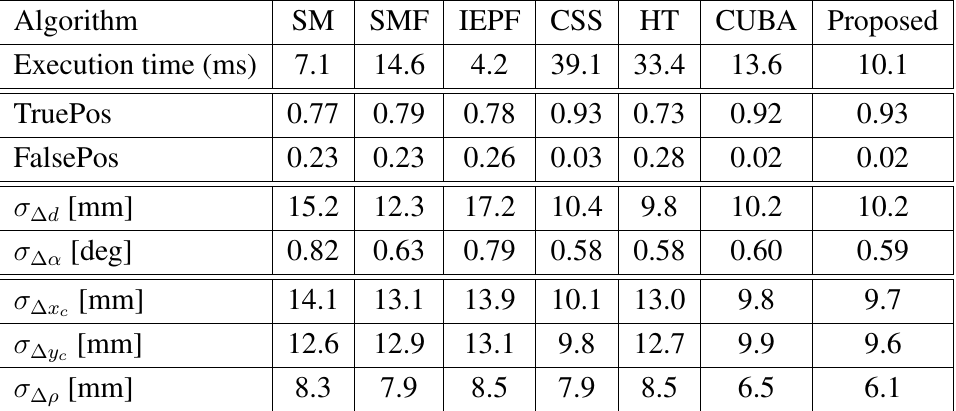
Table 1. Experimental results of several segmentation algorithms (see